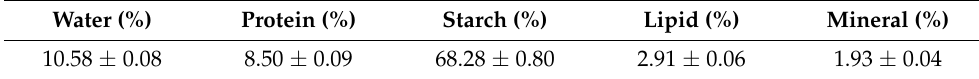
Table 1. The chemical composition of the sorghum flour on wet basis.